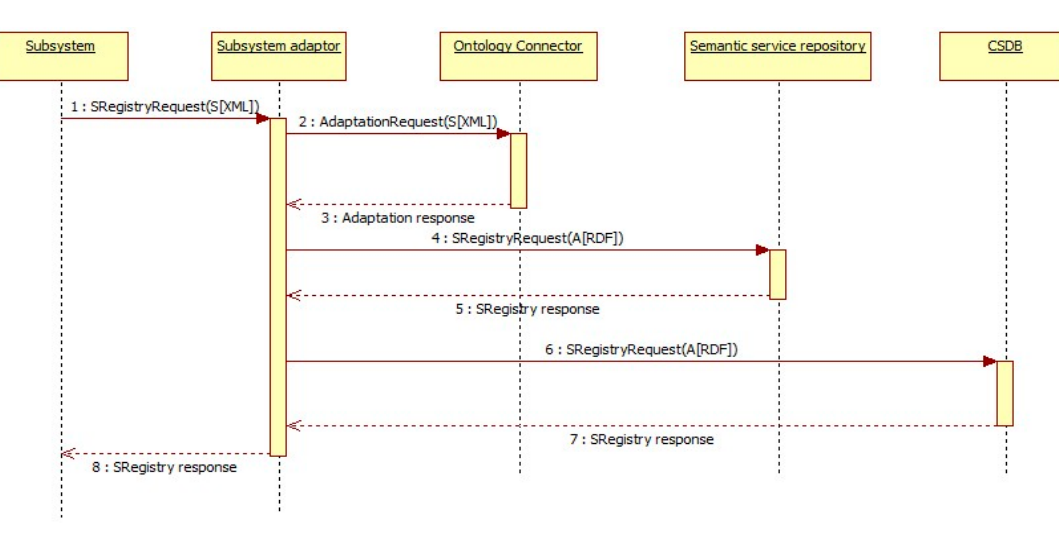
Figure 12. Service registration sequence diagram.